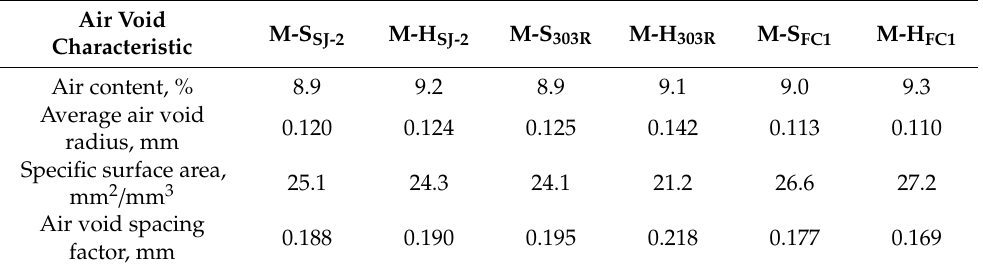
Table 8. Air void characteristics of mortar prepared in di ff erent atmospheric pressures.